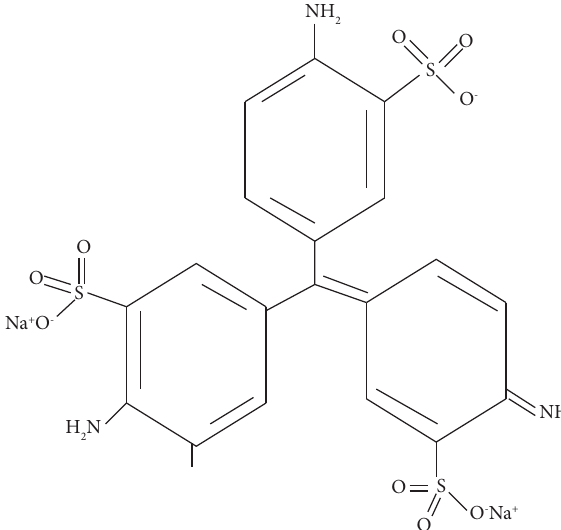
Figure 1: Chemical structure of fuchsine